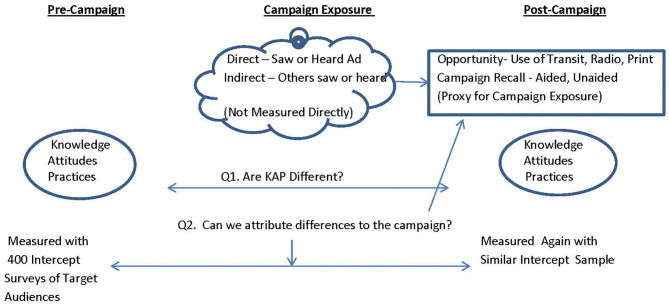
Evaluation design.